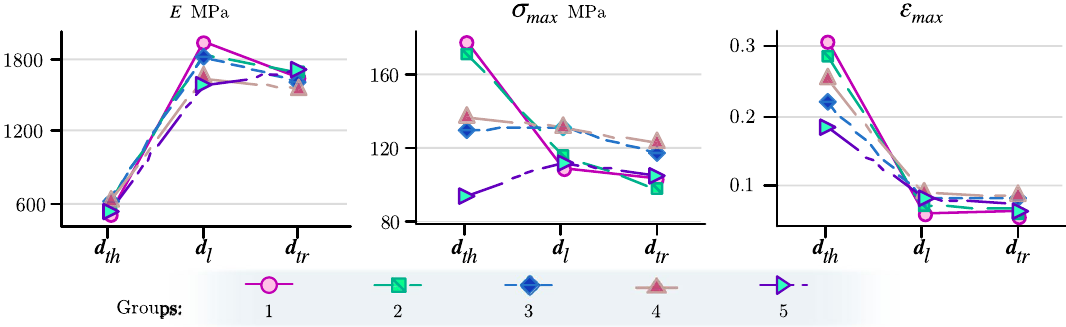
Figure 4. Average values of elastic modulus ( E ), maximum stress ( σ max ), and maximum strain ( ε max ) for five groups of sizes/ages in the three orthotropy directions: thickness ( ddd th ), longitudinal ( ddd l ), and transversal ( ddd tr ).